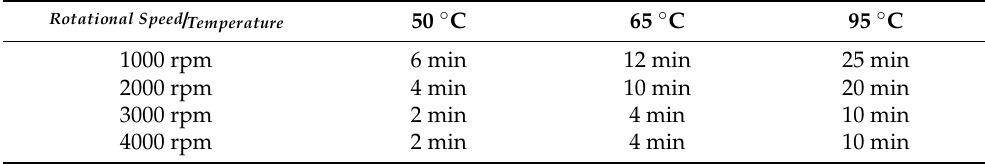
Table 3. Post-exposure bake temperatures and times for SU-8 2075.